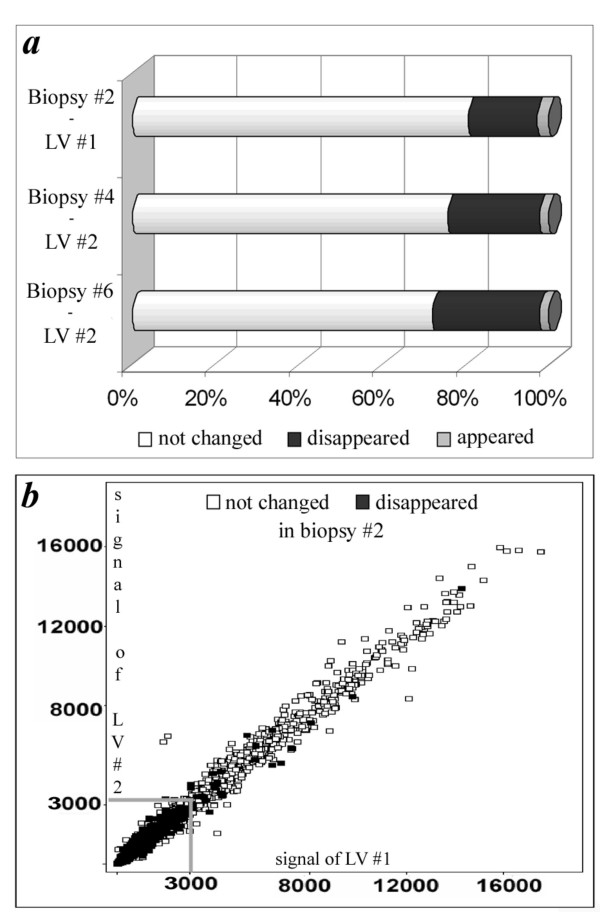
Gene array data analysis. (a) Summary of gene array characteristics, as described in the results section "Amplification results in non-random loss of gene detection". Low intensity means a signal of less than 3000 on the Affymetrix gene chip. (b) Signal intensity plot in which every gene is represented by a square. Signals of parental LVs #1 and #2 are similar, and gene expression data of LV biopsy #2 are visualized in the squares as 'not changed' or 'false negatives'. Biopsy reporters predominantly disappear in the lower expression region of their parental LVs, as exemplified by LV biopsy #2. Data on LV biopsy #4 and 6 are similar.